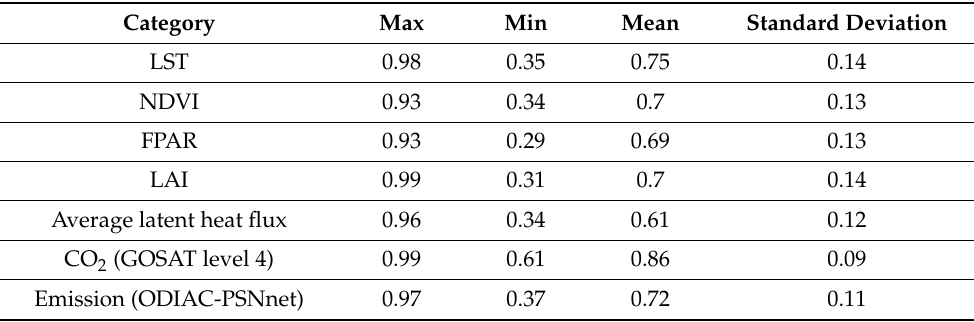
Table 2. Descriptive statistics for Moran’s I estimated from individual